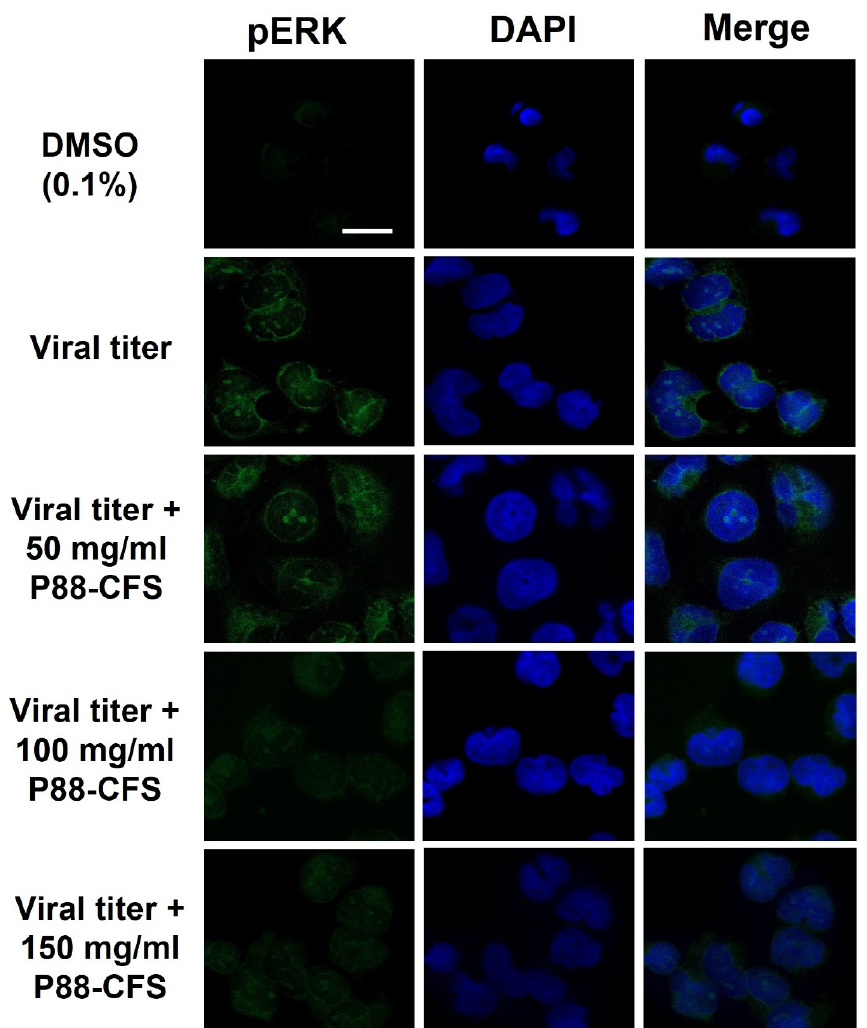
Figure 4. The influence of P88-CFS on p-ERK protein in HEK293 cells after infection with SARS-COV-2. Immunofluorescence was observed using confocal microscopy. The p-ERK expression in SARS-COV-2 infected HEK293 cells was treated with 50, 100 and 150 mg/mL of P88-CFS. DMSO (0.1%) was used as solvent for P88-CFS in all treatment groups. Cells were fixed 12 h post infection and confocal images were collected. Cell nuclei are denoted in blue, p-ERK is denoted in green [Scale bar = 5 µ m].